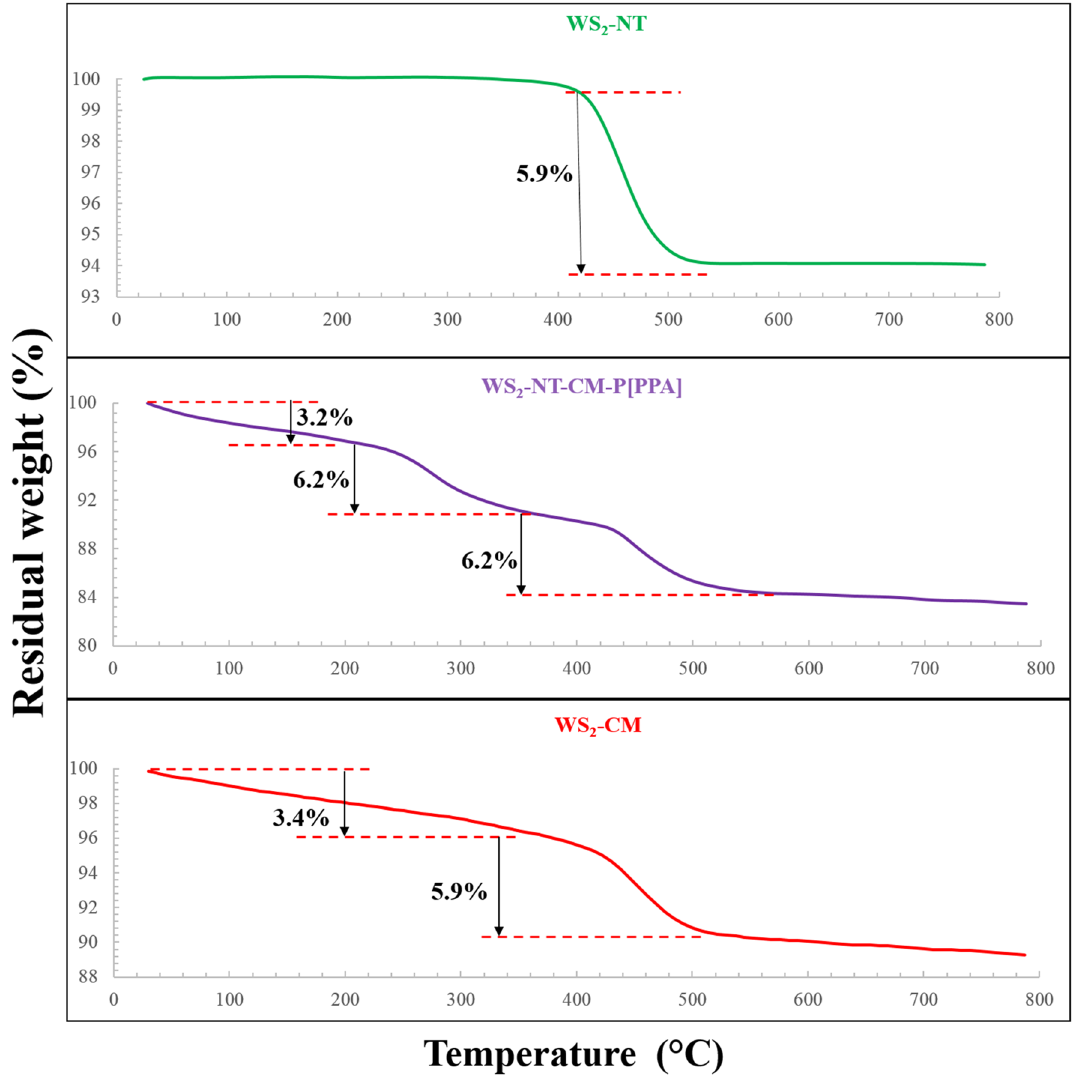
Figure 3. TGA analysis of untreated WS 2 -NTs, CAN-mag-decorated WS 2 -NTs (WS 2 -NT-CM), and CAN-mag- decorated